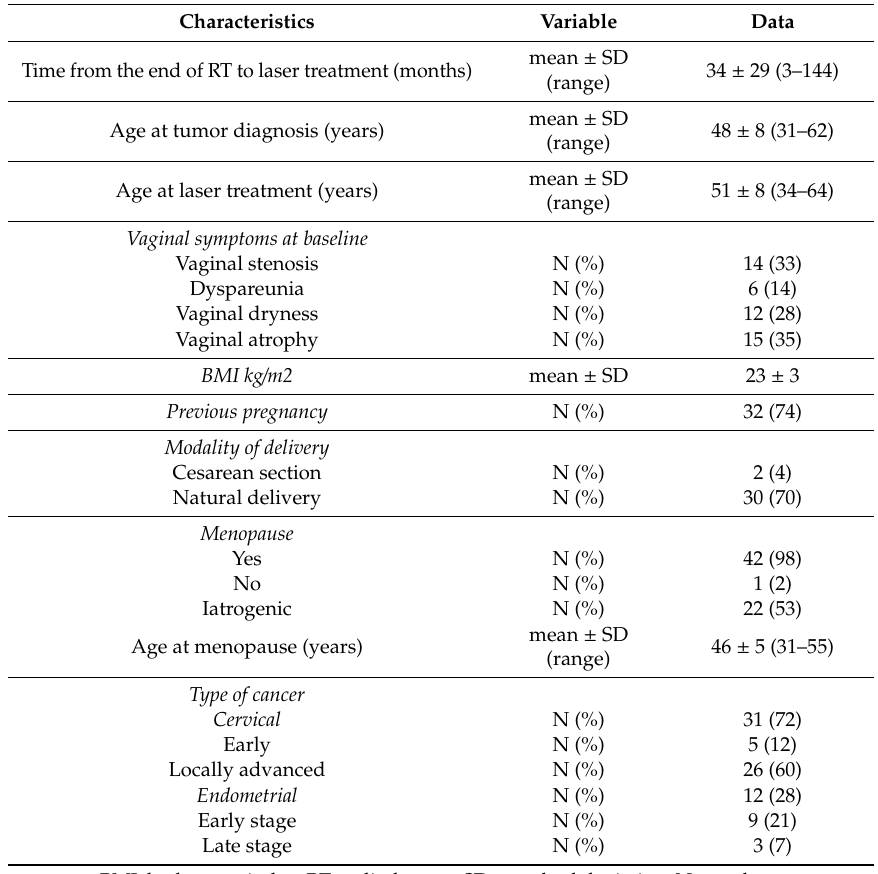
Table 1. Population and tumor characteristics of 43 patients